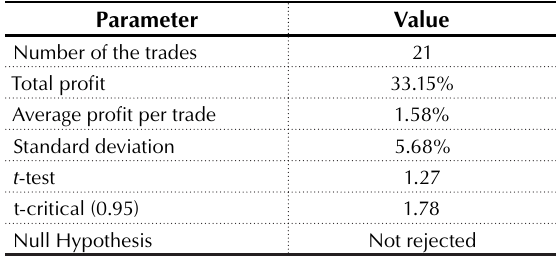
Table 17. T -test for the trading strategy effectiveness evaluation: PFST returns over the period 1991–2018, natural disasters,